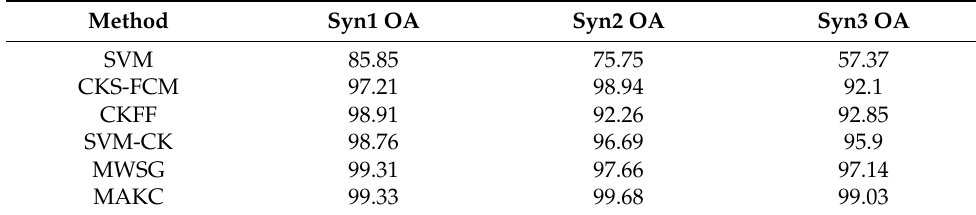
Table 2. Kappa coefficients of different algorithms on the synthetic SAR Table 1. Overall accuracies of different algorithms on the synthetic SAR images.